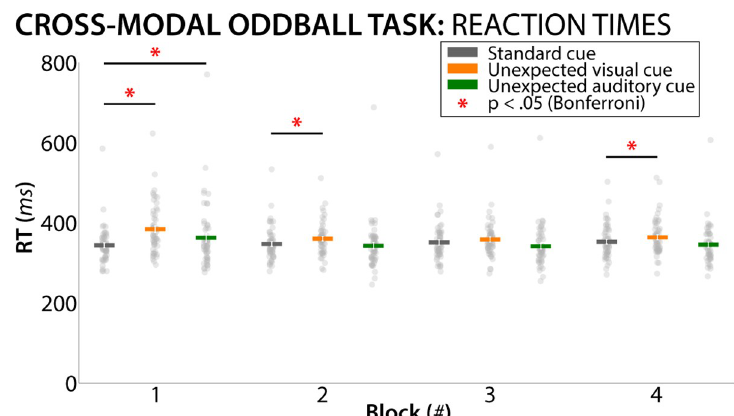
Fig 3. Reaction time data from the cross-modal oddball task. Significant individual comparisons (Bonferroni- corrected) are highlighted in red. For both unexpected auditory and unexpected visual cues, reaction times were slower compared to standard cues in Block 1. This effect wore off over time. White error bars denote the standard error of the mean, gray dots indicate individual subject condition means.